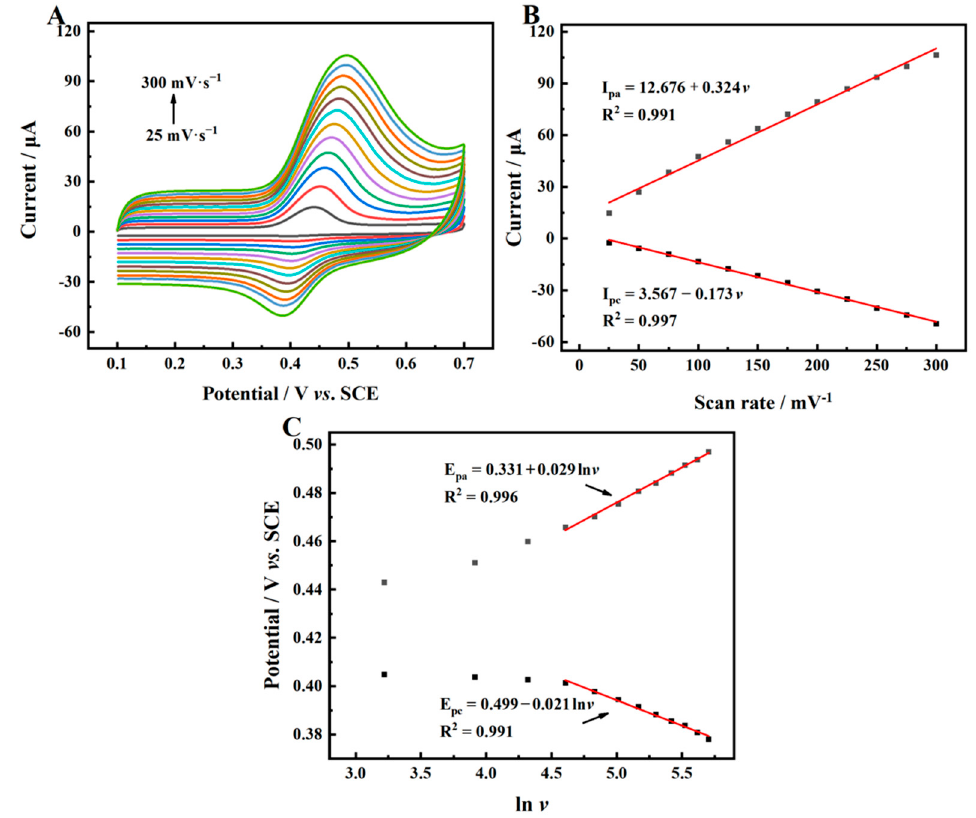
Figure 7. ( A ) CVs of 10.0 µ M baicalein on TiO 2 -MXene/PEDOT:PSS/GCE in 0.1 M PB (pH 2.0) at different scan rates ( v ) from 25 to 300 mV · s − 1 ; ( B ) The relationship between I p and v ; ( C ) The relationship between E p and ln v .